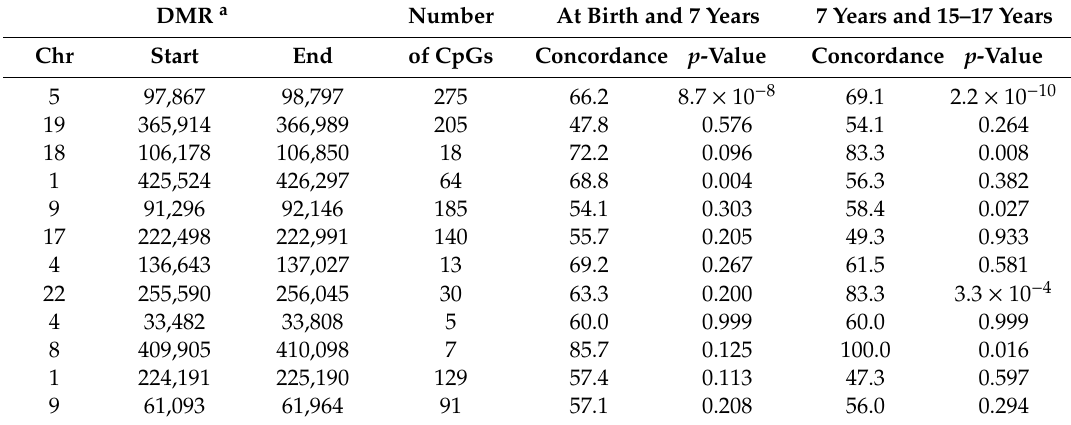
Table 5. Directional concordance between time points for each individual CpG belonging to the same